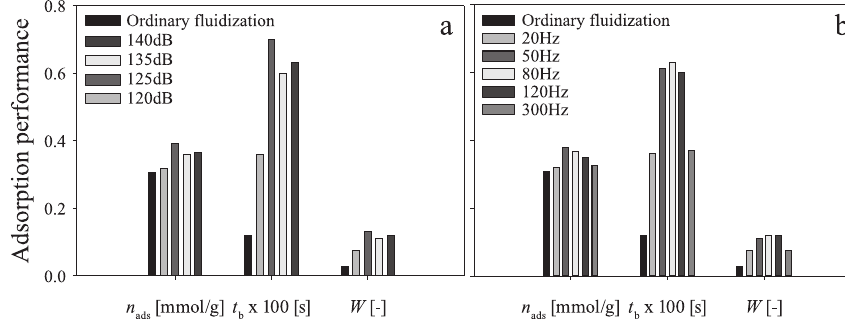
Fig. 17 Effect of (a) SPL (at fixed f , 80 Hz) and (b) f (at fixed SPL , 140 dB) on CO 2 adsorption in terms of n ads , t b and W . u = 1.5 cm/s; C 0 = 10 %vol.; f = 80 Hz.